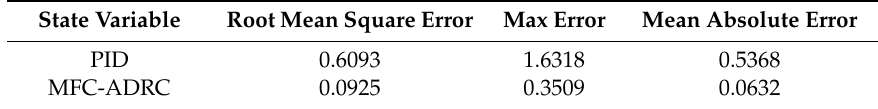
Table 7. Statistical indicators for proportional integral derivative (PID) and MFC-ADRC controllers.